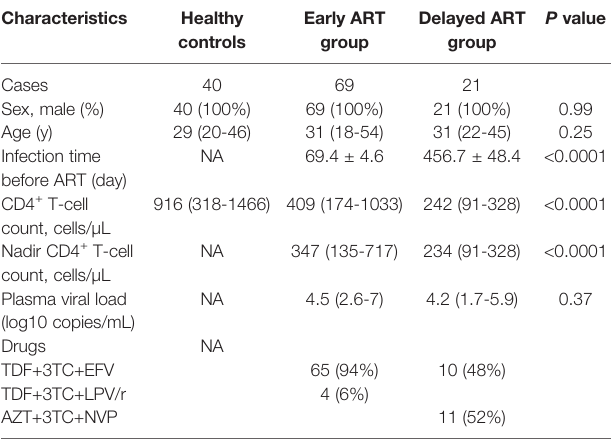
TABLE 1 | Characteristics of all the study